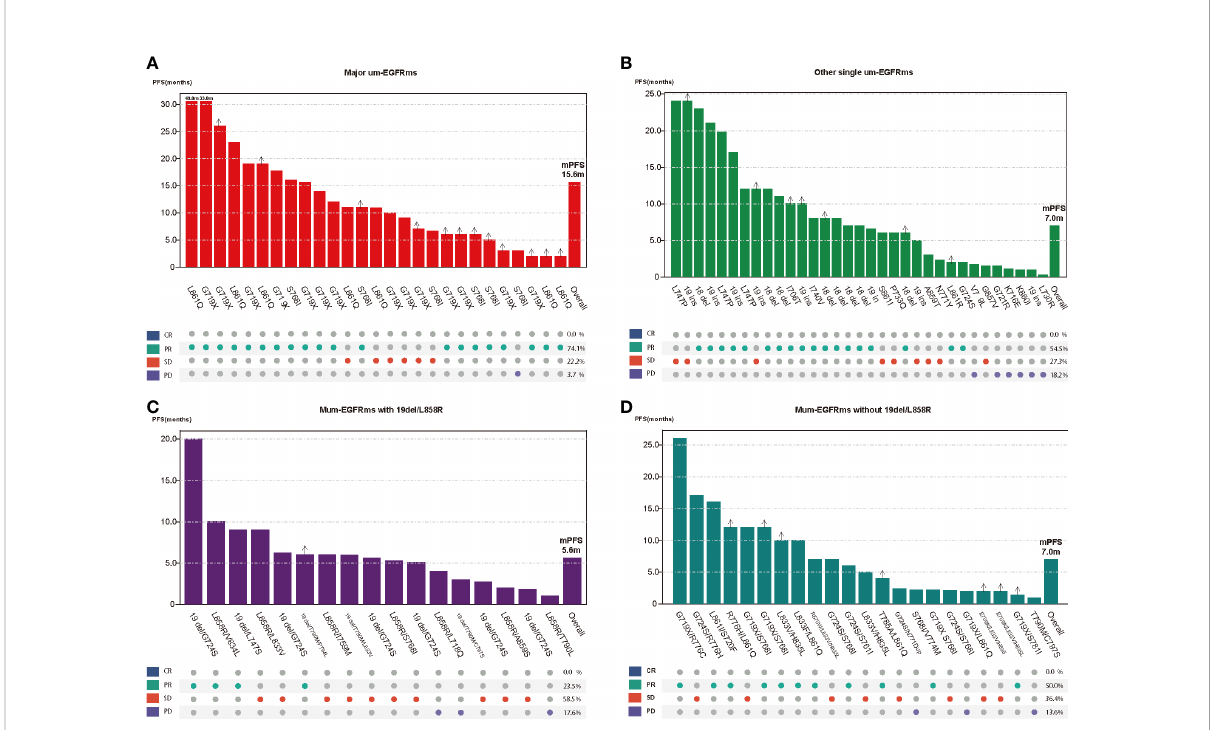
FIGURE 6 Tumor response and progression free survival (PFS) of each individual patient as well as overall tumor response rate and median PFS for each group ( A : Major ucm-EGFRms; B : Other single ucm-EGFRm; C : multiple ucm-EGFRms that with 19del/L858; D : multiple ucm-EGFRms that without 19del/L858R).